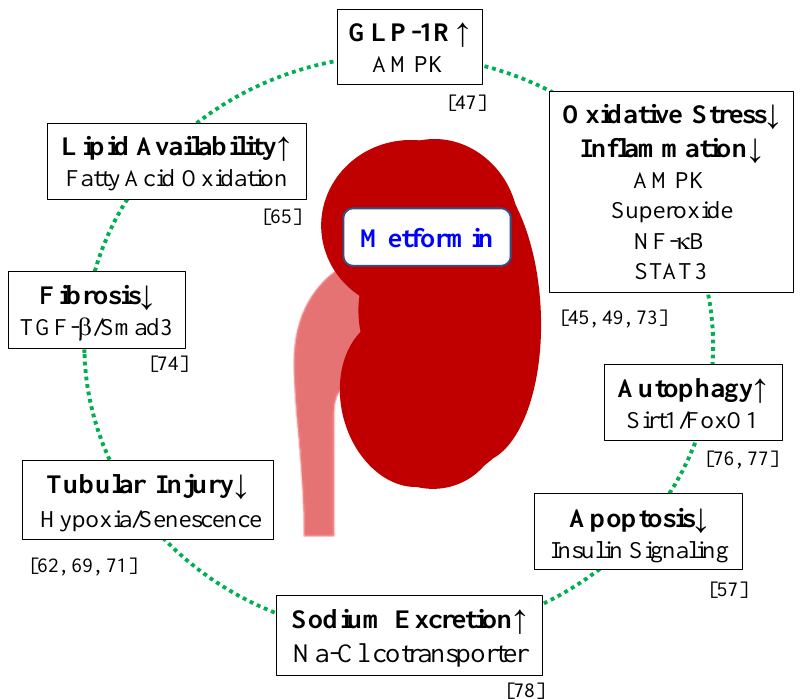
Figure 2. Renoprotective mechanisms of metformin. Metformin attenuates DKD in glucose lowering- dependent and glucose lowering-independent manners. AMPK plays an important role in the glucose-lowering effects as well as the pleiotropic effects of metformin. Metformin reduces the body weight (e.g., via GDF15 and GLP-1) and improves insulin resistance, activities that may underlie the beneficial effects of metformin on DKD. DKD: diabetic kidney disease, AMPK: AMP-activated kinase, GDF15: growth differentiating factor 15, GLP-1: glucagon-like peptide 1, GLP-1R: glucagon-like peptide 1 receptor.